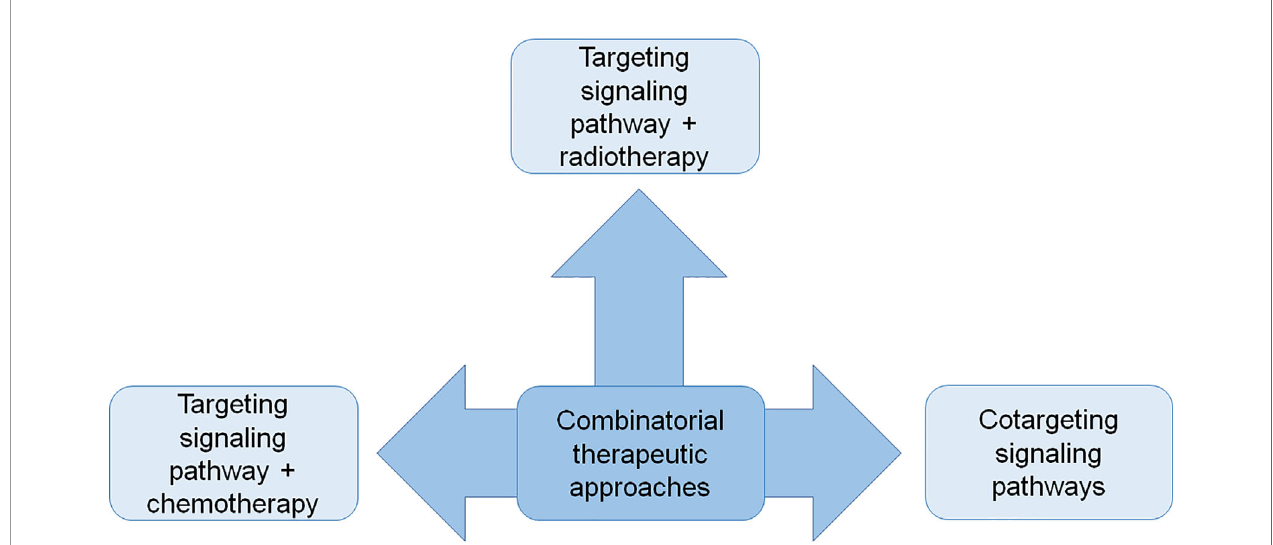
FIGURE 1 | The schematic diagram shows combinatorial strategies to fi ght CSCs applied in the preclinical studies described in the